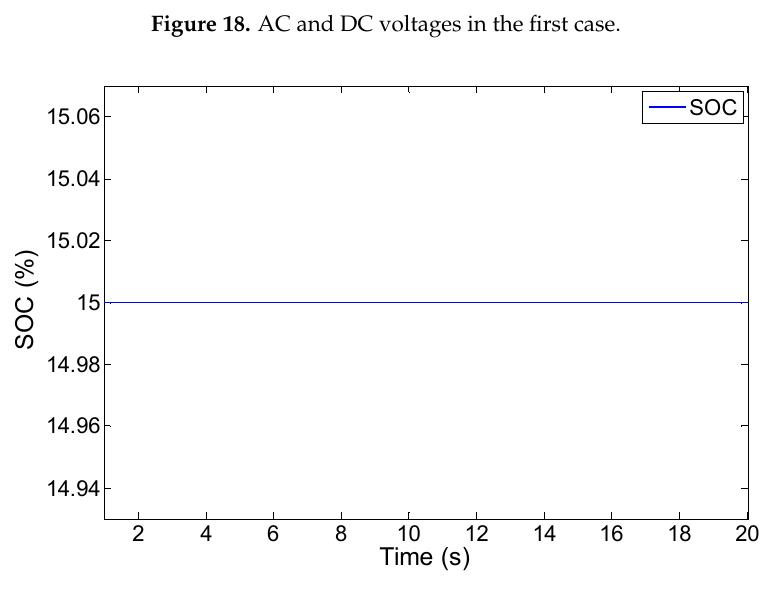
Figure 19. Battery SOC in the first case.